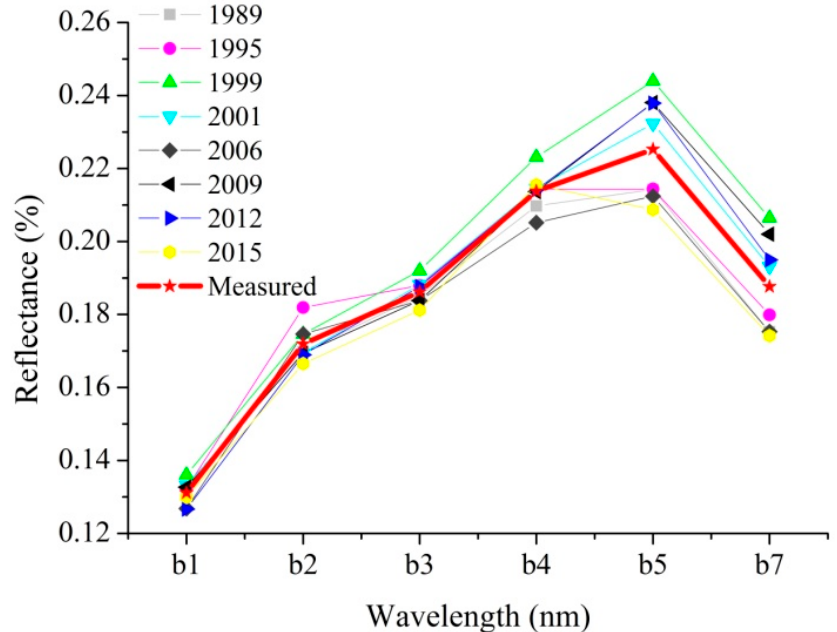
Figure 4. Mean spectra of 238 sites after atmospheric correction compared with that of in situ measurement.